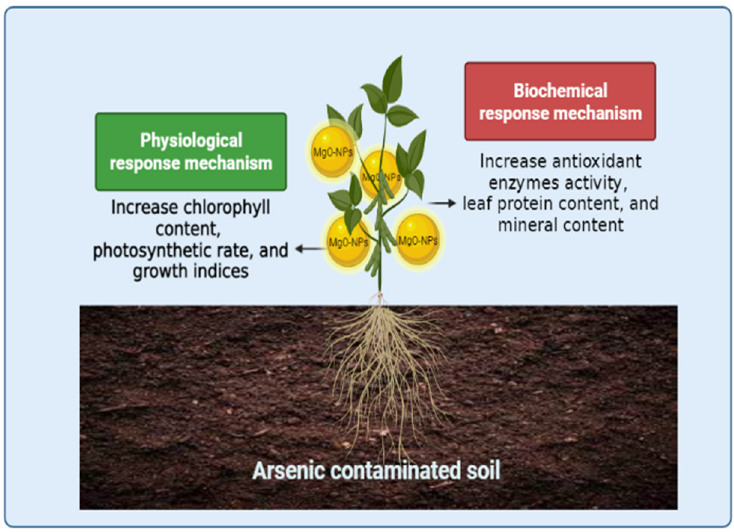
Figure 6. A working model of the physiological and biochemical responses of soybeans growing in As contaminated soil and sprayed with